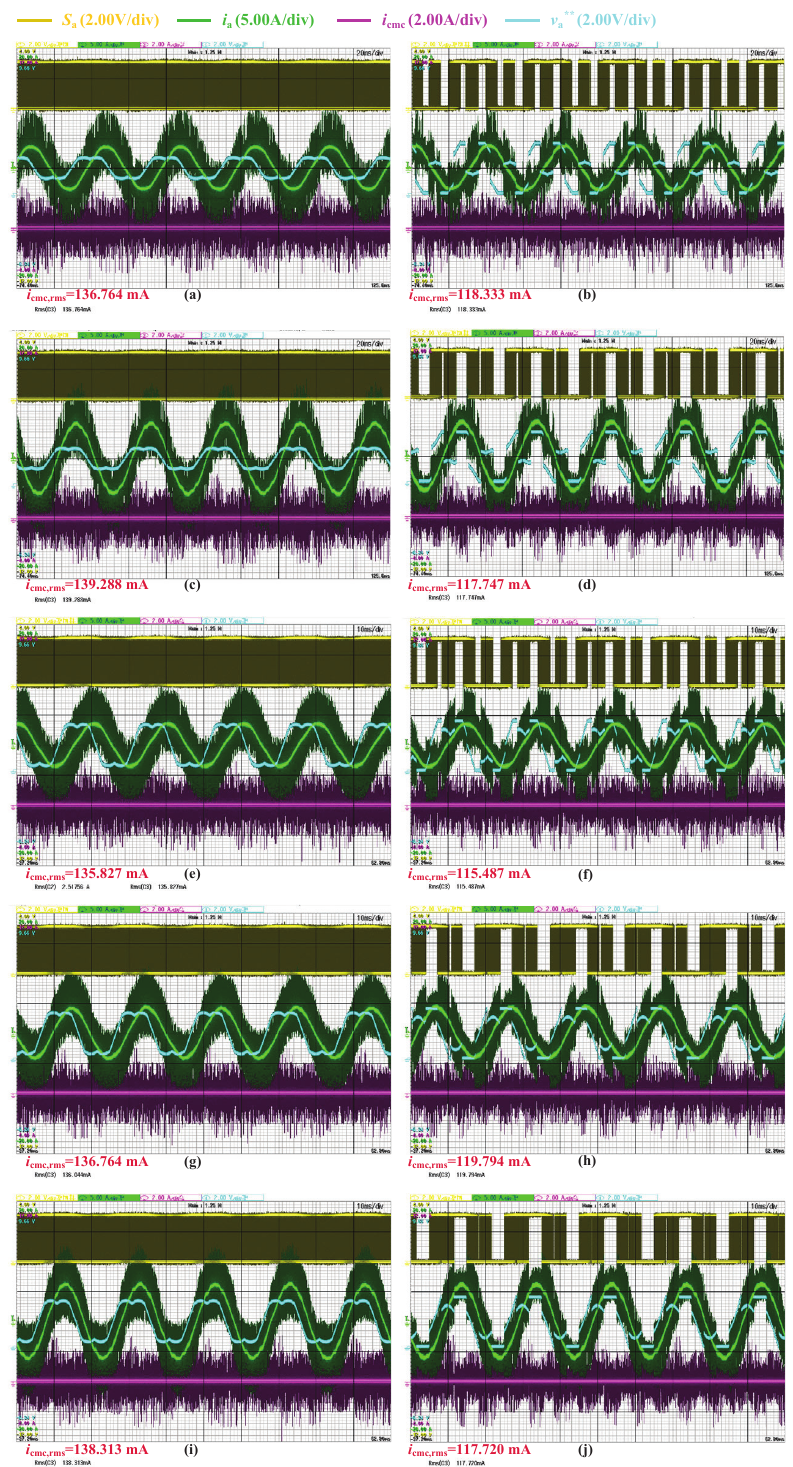
Figure 10. Steady − state output waveforms with SVPWM and MSL-DPWM methods at f s = 10 kHz with different operating conditions: ( a ) SVPWM at f o = 25 Hz and no load, ( b ) MSL-DPWM at f o = 25 Hz and no load, ( c ) SVPWM at f o = 25 Hz and half load, ( d ) MSL-DPWM at f o = 25 Hz and half load, ( e ) SVPWM at f o = 50 Hz and no load, ( f ) MSL-DPWM at f o = 50 Hz and no load, ( g ) SVPWM at f o = 50 Hz and half load, ( h ) MSL-DPWM at f o = 50 Hz and half load, ( i ) SVPWM at f o = 50 Hz and full load, and ( j ) MSL-DPWM at f o = 50 Hz and full